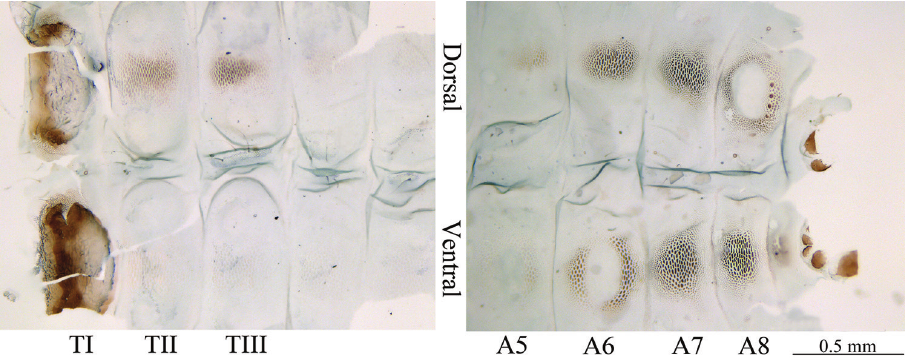
Figures 7. Final instar larva in leaf-mine, showing sclerotized plate and granules on the body, registered No.